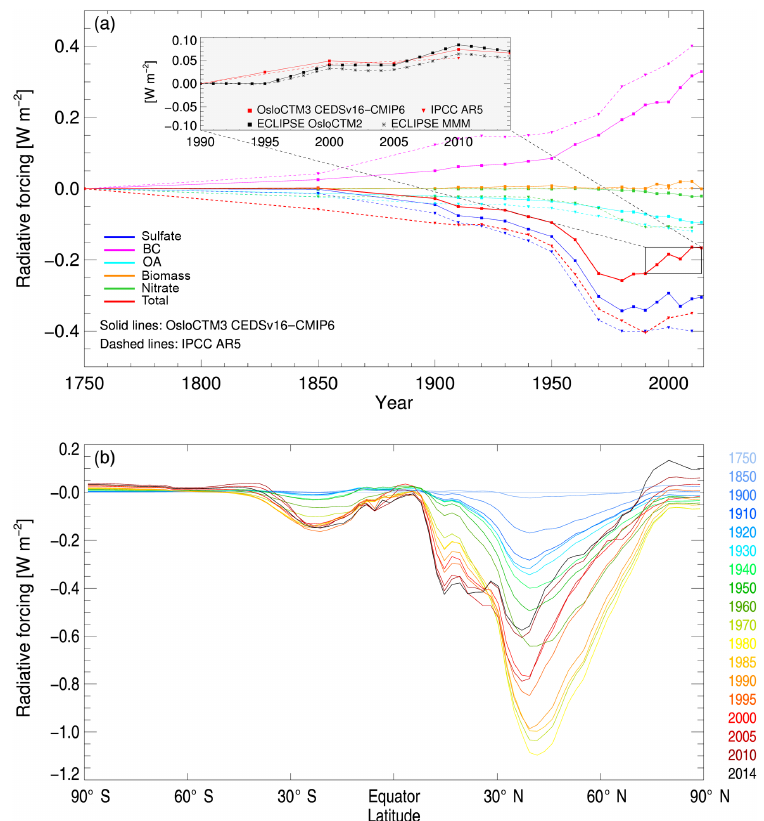
Figure 8. (a) Time evolution of RFari. Solid lines show Oslo CTM3 results from the current study, while dashed lines show results from IPCC AR5 (Myhre et al., 2013b). The inset shows the change in total RFari between 1990 and 2015 in the current study compared with IPCC AR5 and multi-model mean and Oslo CTM2 results from Myhre et al. (2017) using ECLv5 emissions. (b) Zonal mean RFari